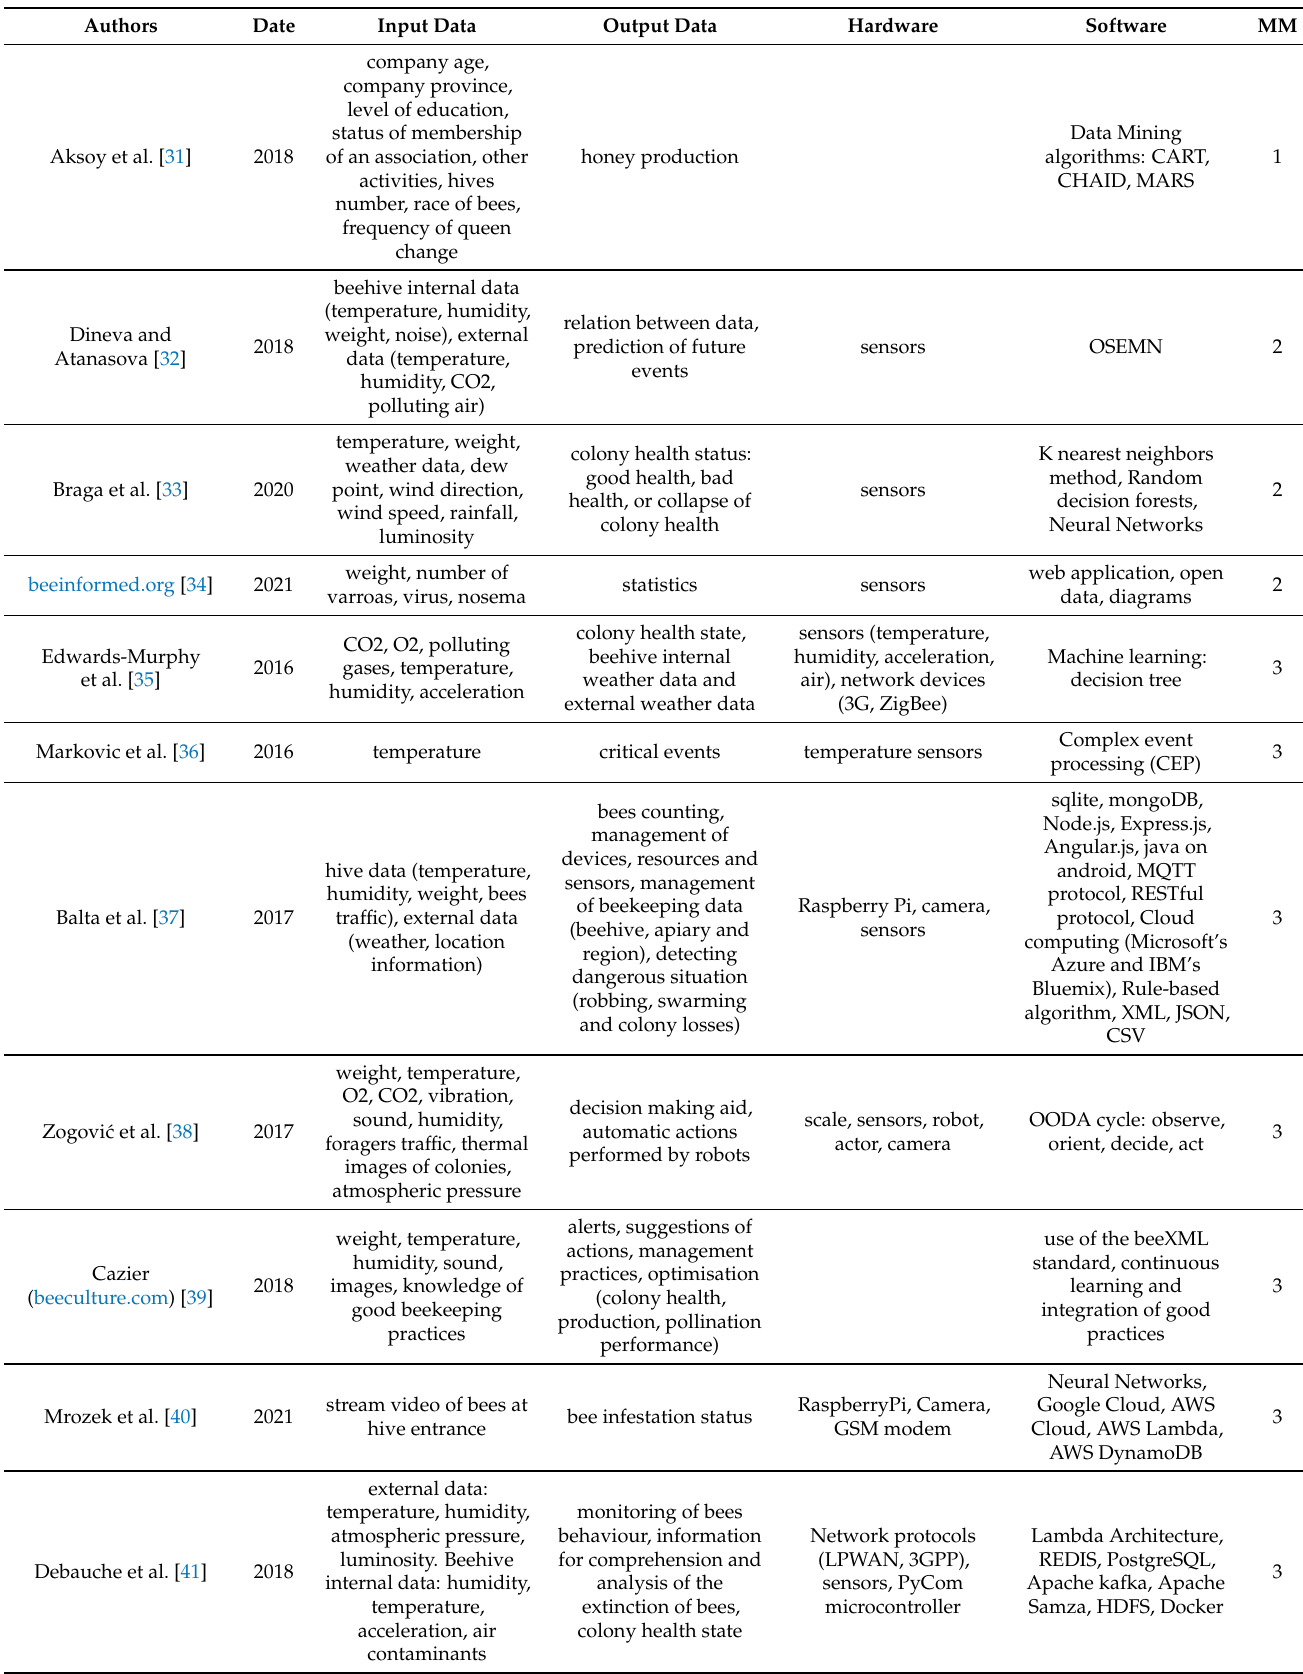
Table 2. Literature about smart beehives analysed with the Maturity Model presented in the Table